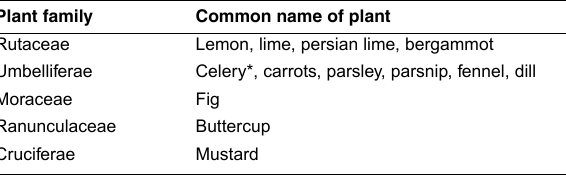
TABLE 1 Common plants associated with phytophotodermatitis Plant